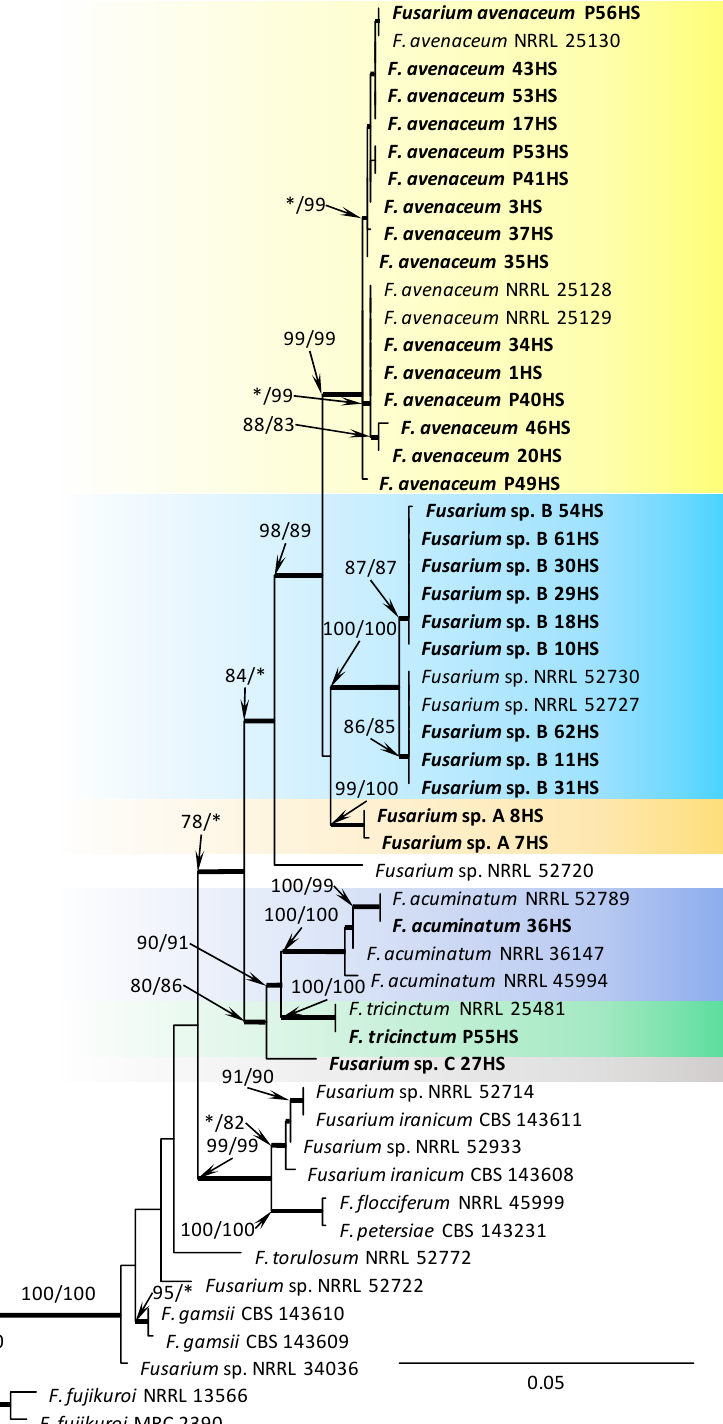
Figure 4. Phylogram obtained from Maximum Likelihood (ML) analysis of the combined dataset of RPB2 + TEF1- α for selected species of the Fusarium tricinctum SC. Sequences obtained during this study are presented in bold font. The Bootstrap values ≥ 75% for ML and Maximum Parsimony (MP) analyses are presented at nodes as follows: ML/MP. Bold branches indicate posterior probabilities values ≥ 0.95 obtained from Bayesian Inference (BI) analyses. * Bootstrap values <75%. The tree is drawn to scale (see bar) with branch length measured in the number of substitutions per site. Fuarium fujikuroi represents the outgroup in the analysis of the combined dataset of RPB2 + TEF1- α .